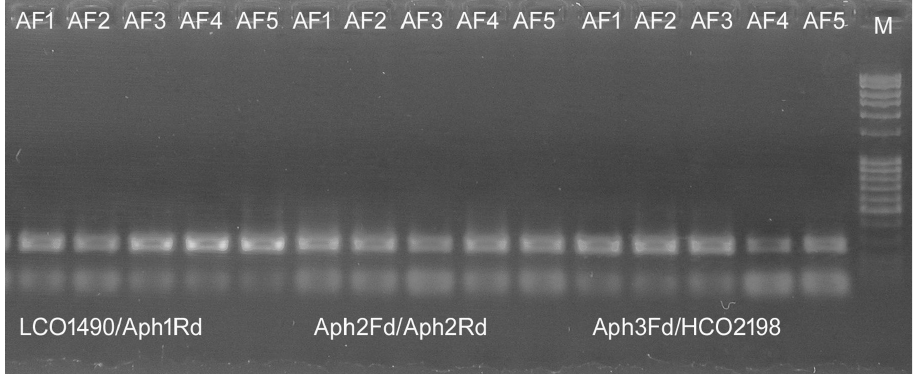
Figure 2. Agarose gel visualizing the products of direct PCR in initial trials testing the novel primers with fresh Aphidius samples. Three direct PCR reactions were conducted with the following primer pairs: 1 LCO1490/Aph1Rd 2 Aph2Fd/Aph2Rd; and 3 Aph3Fd/HCO2198. The species included in trials were: AF1- A. tanacetarius , AF2- A. sussi , AF3- A. sonchi , AF4- A. linosiphonis and AF5- A. ribis . M –